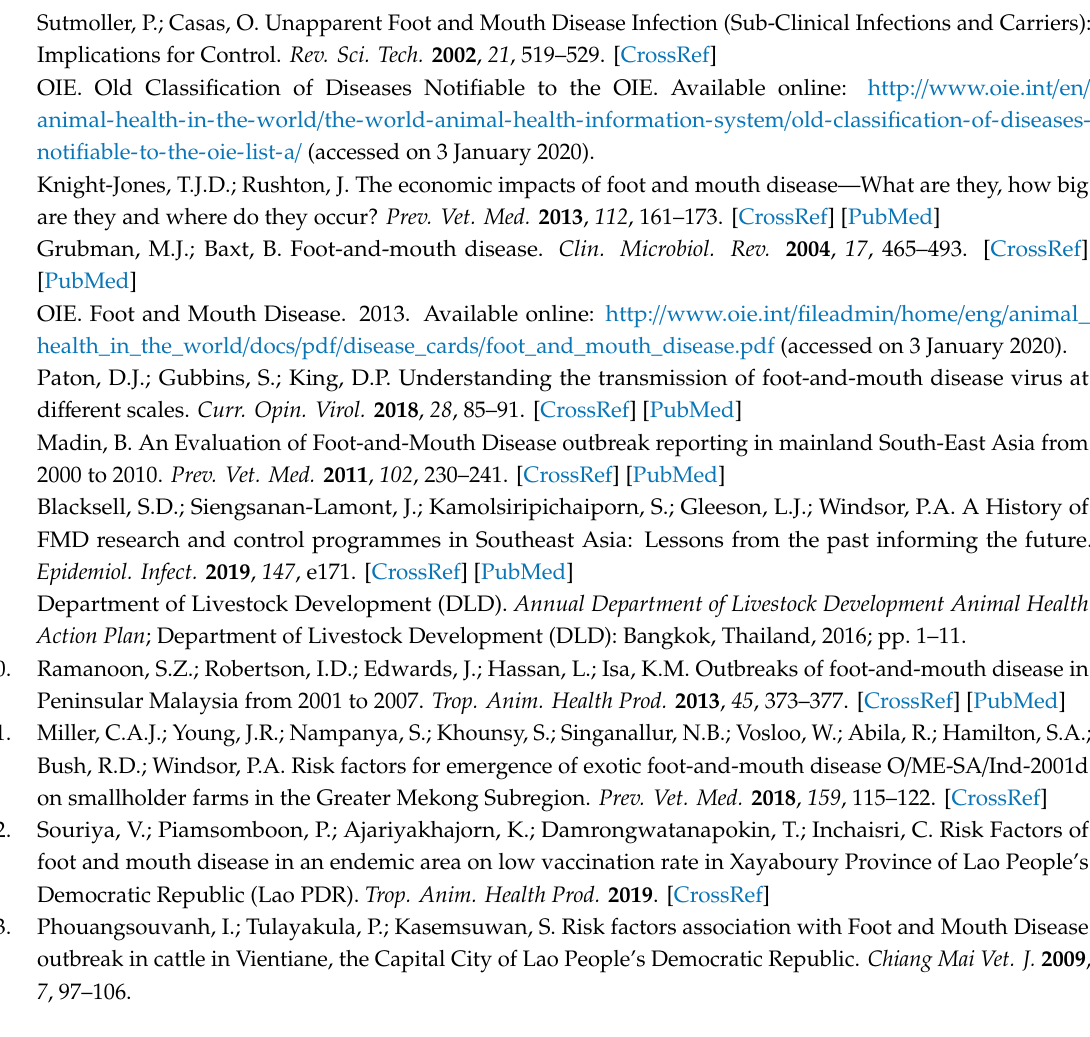
Table S1: Description of variables used in questionnaires, Table S2: Univariable analysis of risk factors and FMD outbreak in the study area, Table S3: Results from chi-square test show collinearity between a pair of risk